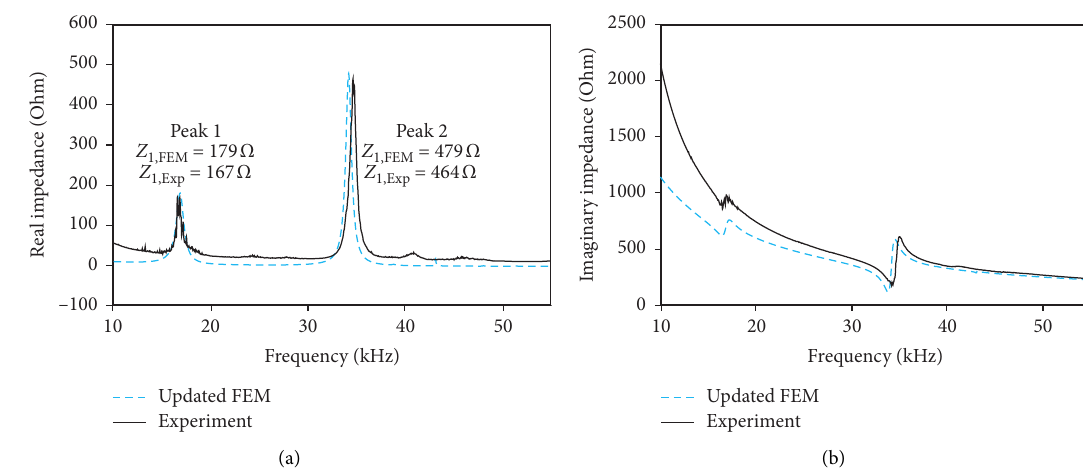
Figure 14: EMI responses after updating peak magnitudes. (a) Real impedance. (b) Imaginary